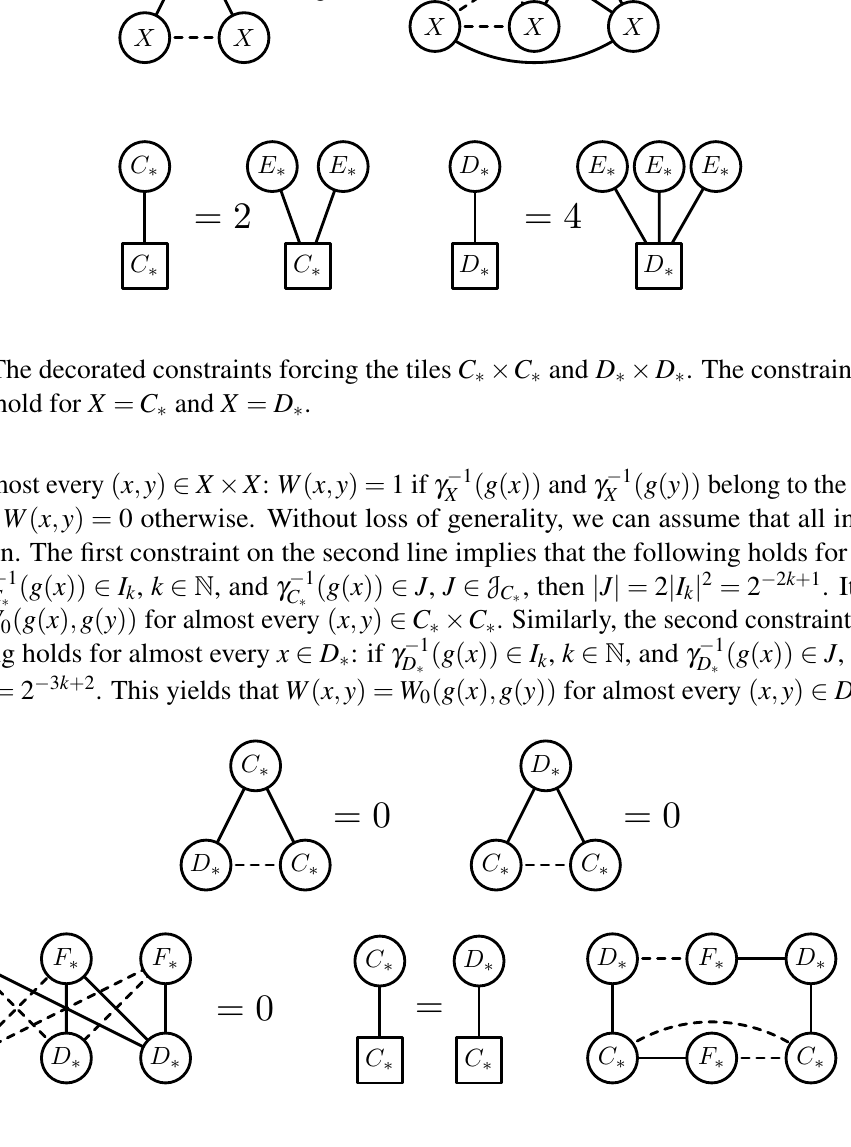
Figure 14: The decorated constraints forcing the structure of the composite tile C ∗ × D ∗